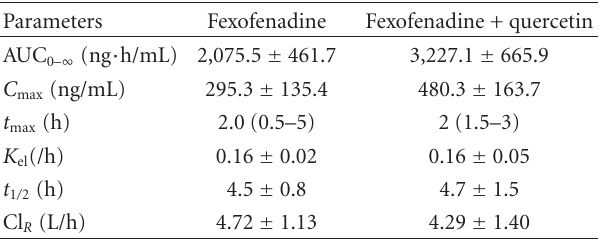
Table 30: Pharmacokinetic parameters of fexofenadine (60mg) and in combination quercetin (500) mg after a single-dose administra- tion